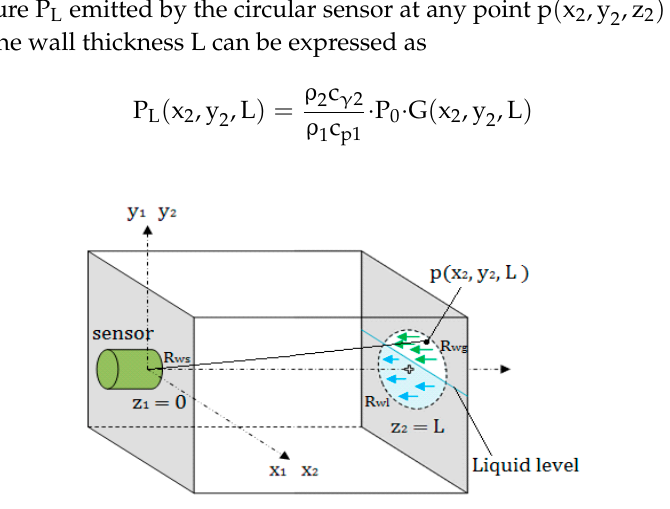
Figure 3. Calculation of echo energy.